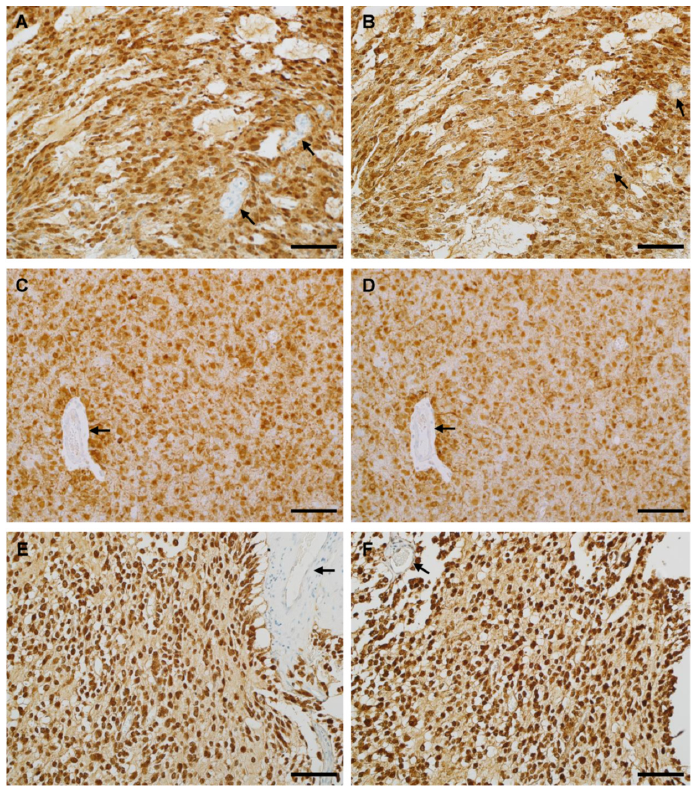
Figure 4. Immunoreactivity for IDH1 R132H in IDH1 -muted gliomas including anaplastic astrocy- toma (AST-19; A , B ), oligodendroglioma (AST-18; C , D ), and secondary glioblastoma (GLB-9; E , F ) as stained separately with MRQ-67 ( A , C , E ) and H09 ( B , D , F ) on serial FFPE tissue sections. All of the tumor cells were labelled in a cytoplasmic and nuclear pattern, but blood vessels (arrow) were not. UltraView, visualized with DAB, and counterstained with hematoxylin. Scale bar = 100 µm.